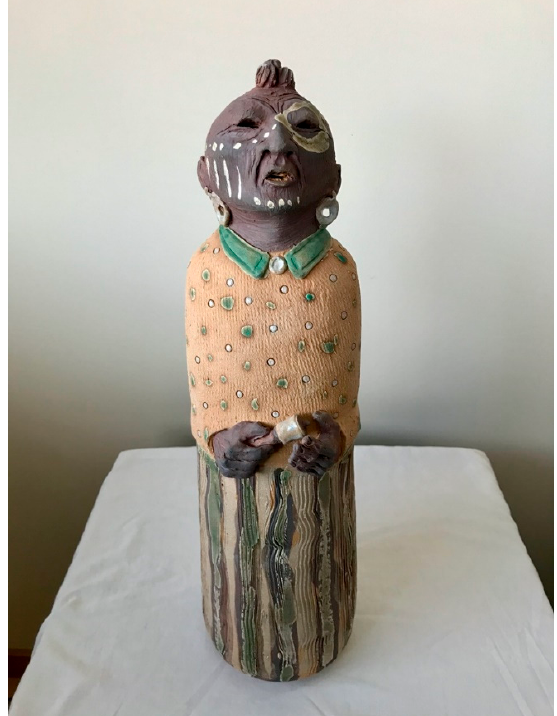
Figure 14. Peter Jones, Old Singer , 2016, Clay, with permission of the artist.